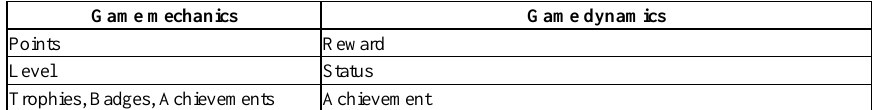
Table 1. Gamification Design/Model Used